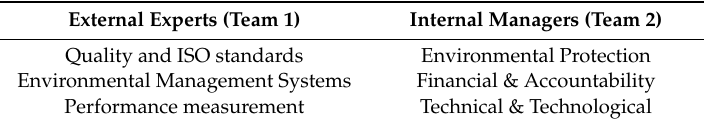
Table 1. Role and fields of expertise for External Experts (Academic Group) and Internal Experts (Company Group) involved in the